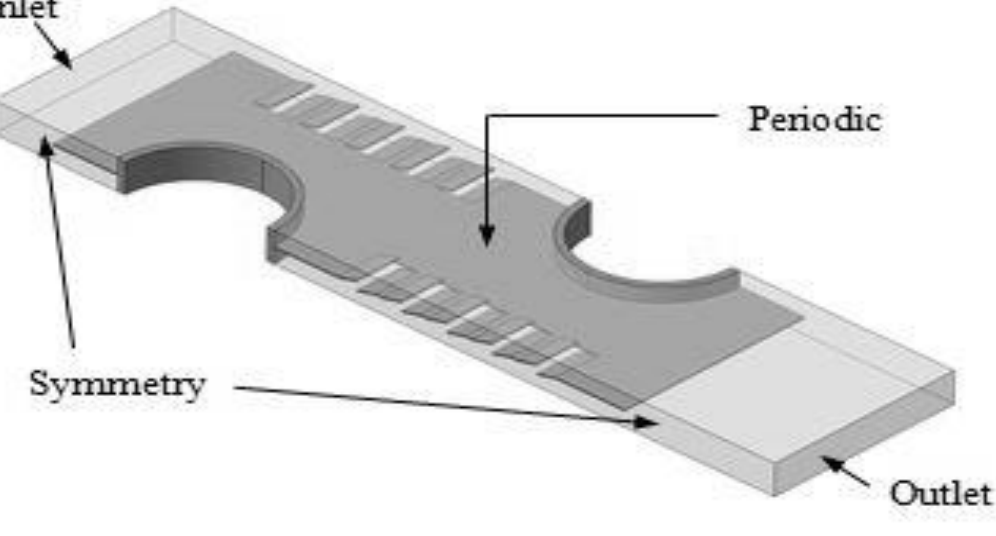
Figure 6: Fluid zone (shaded) round the louvered fin (opaque)